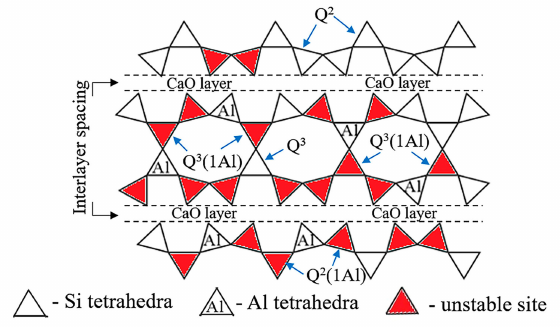
Figure 8. Schematic diagram showing unstable substitution sites in the structure of Al-substituted tobermorite.